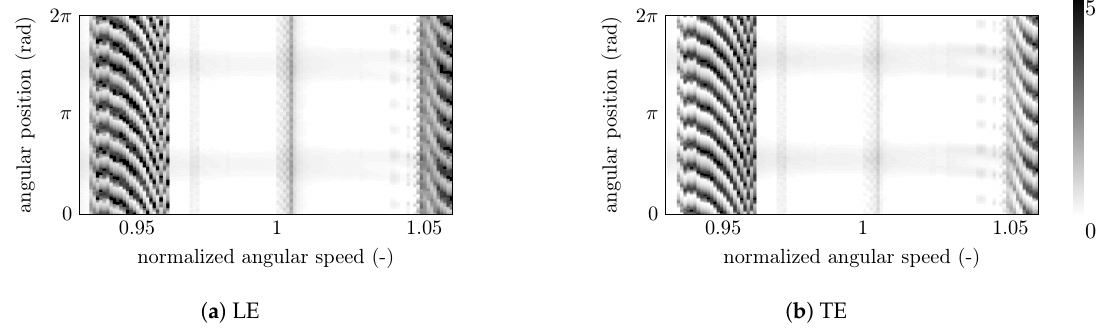
Figure 18. Evolution of the wear profile with the angular speed for the HP compressor blade.